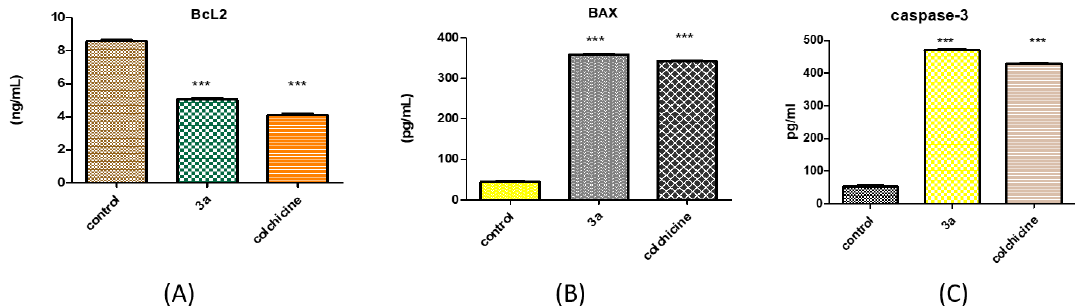
Figure 14. Concentrations of ( A ) Bcl-2 (concentrations 32, 16, 8, 4, 2, 1, 0.5 ng/mL); ( B ) BAX (concentrations 2000, 1000, 500, 250, 125, 62.5, 31.25 pg/mL), and ( C ) caspase-3 expression (2500, 1250, 625, 313, 156, 78, 39 pg/mL) for 3a and colchicine on leukemia SR cell line relative to control. Results significantly different from control at *** p < 0.05. Table 8. Bax and Bcl-2 conc ± SD and fold change levels for compounds 3a and colchicine on leukemia SR cell line.